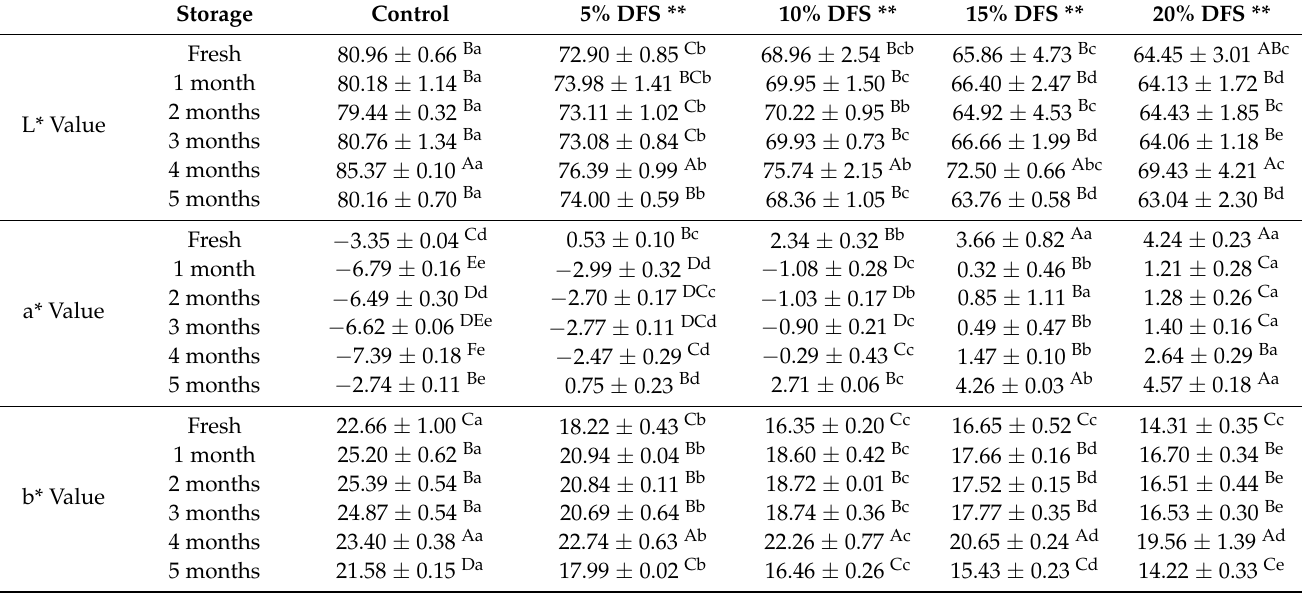
Table 3. Effect of different DFS% on color parameters during